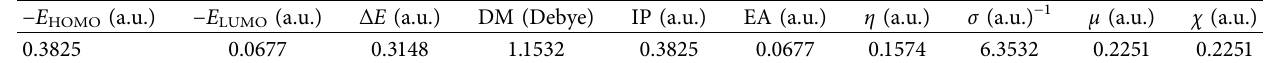
Table 5: The calculated quantum chemical parameters obtained from DFT calculations of lawsone. − E − E HOMO (a.u.) LUMO (a.u.)